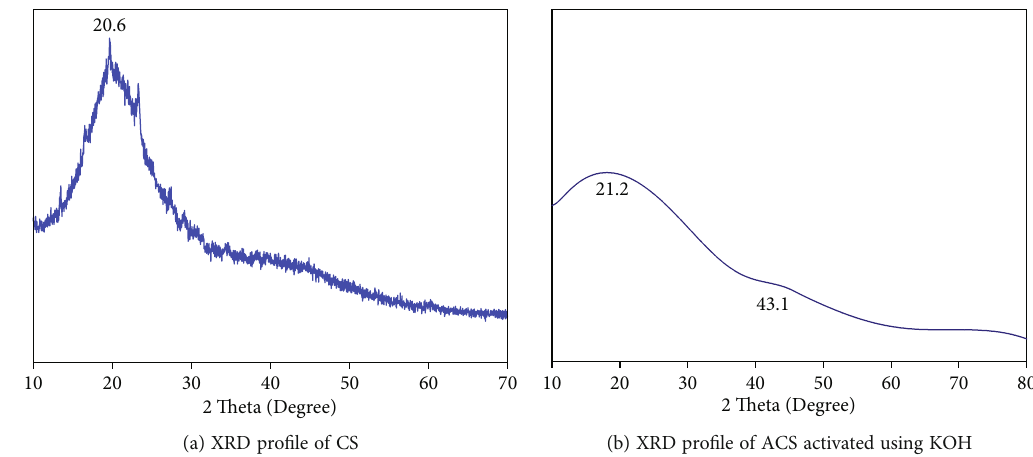
Figure 1: (a, b) XRD pro fi le of CS and ACS.